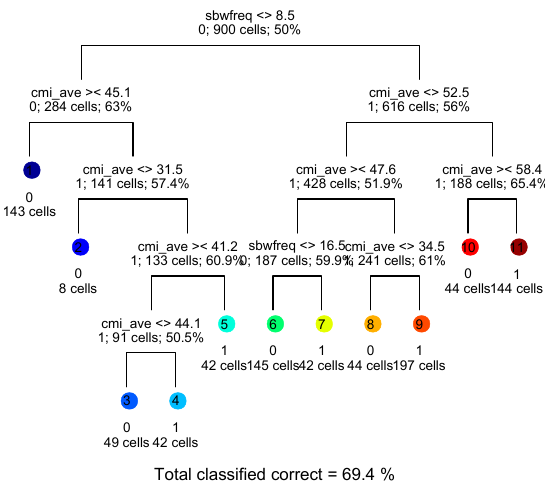
Figure 6. Classification tree of the presence (1) or absence (0) of the interaction between fire and spruce budworm defoliation as a function of just the two most important explanatory variables (Figure 5) from the data used to grow the tree shown in Figure 3. These two variables are the frequency of defoliation by spruce budworm (sbwfreq) and the annual average climate moisture index (cmi_ave). See the caption to Figure 3 for additional detail.